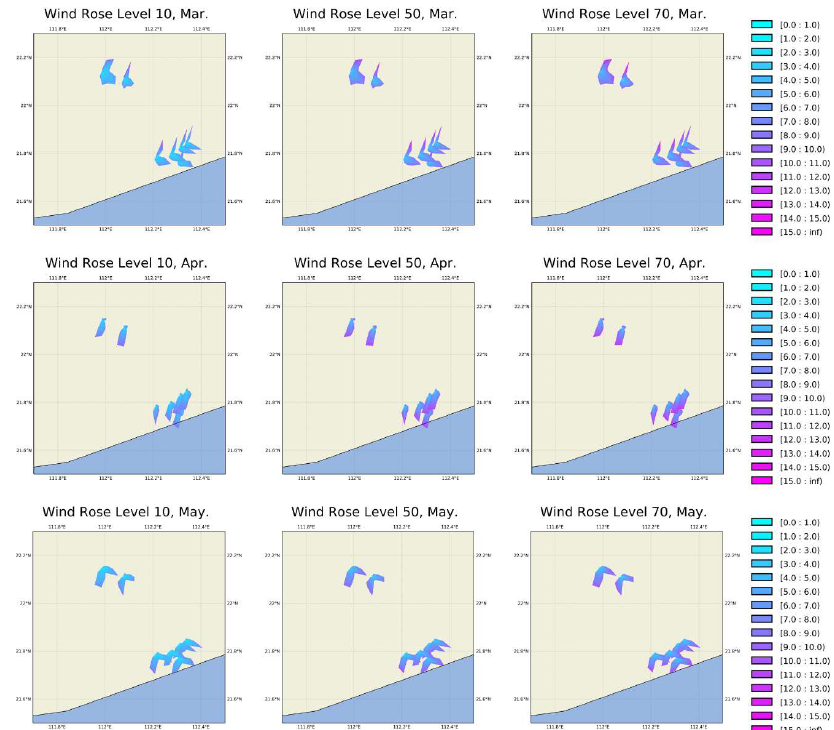
Figure A1. Wind rose of the Test 2 results in the seven tower positions in spring (Mar., Apr., and May).